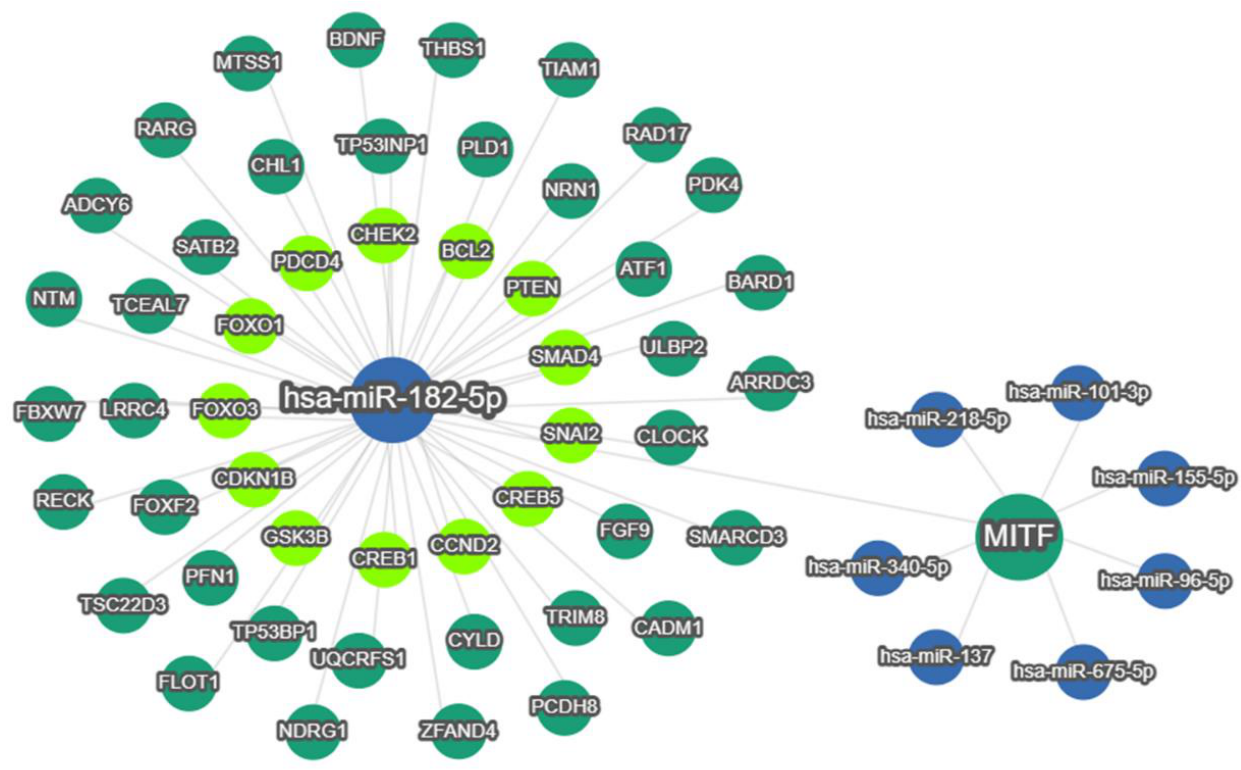
Figure 6. miRTargetLink2.0 visualisation of miR-182-5p and MITF bidirectional interactions. miR-182-5p and MITF were input items, while the connected nodes were gene/miRNA interactions validated by strong experimental evidence (qRT-PCR, Western blot and Luciferase reporter assay). Blue nodes: miRNAs; Green nodes: genes; Bright green nodes: genes significantly associated with prostate cancer and/or EMT.